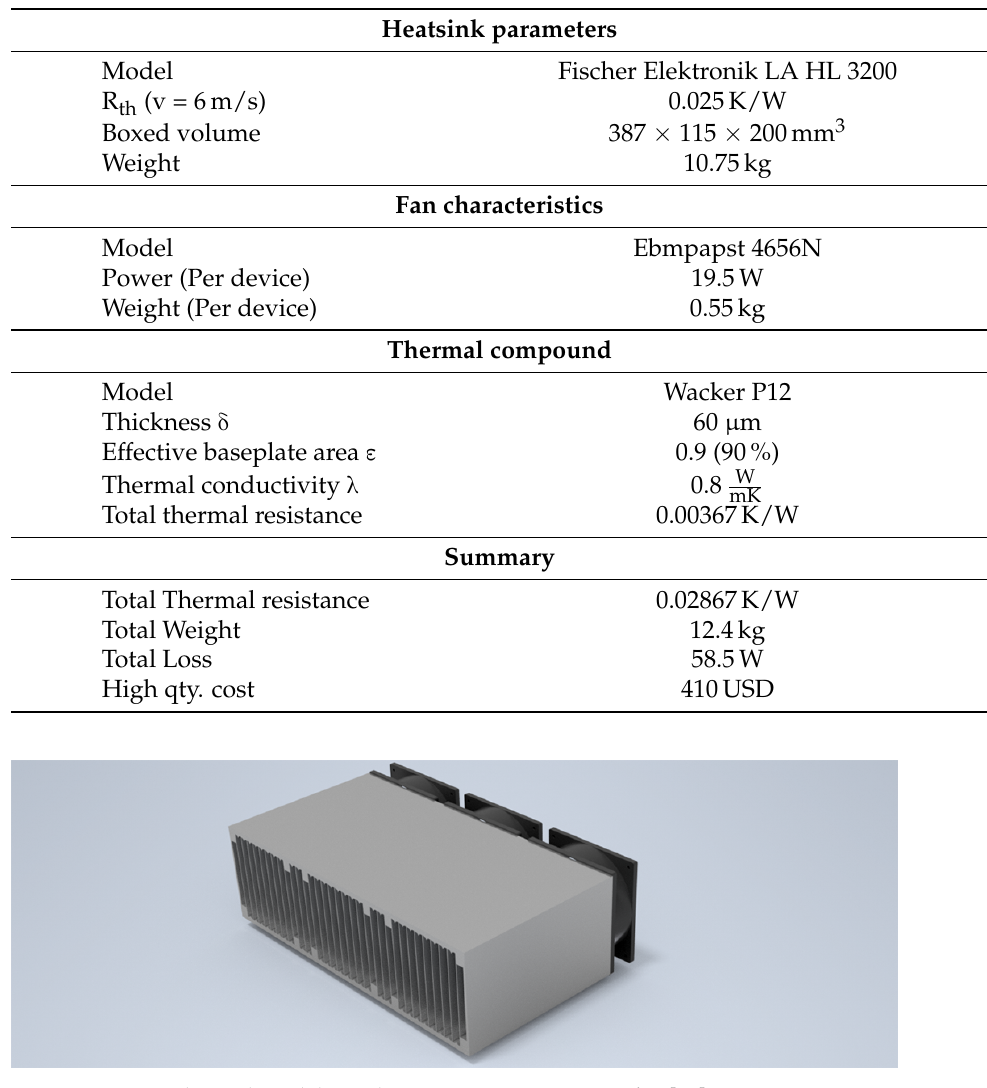
Table 4. Components and characteristics of the selected cooling solution.